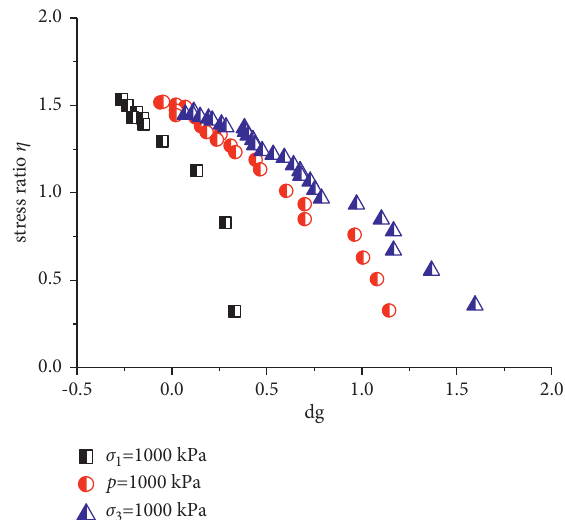
Figure 2: Stress-dilatancy of gravel along different loading paths.